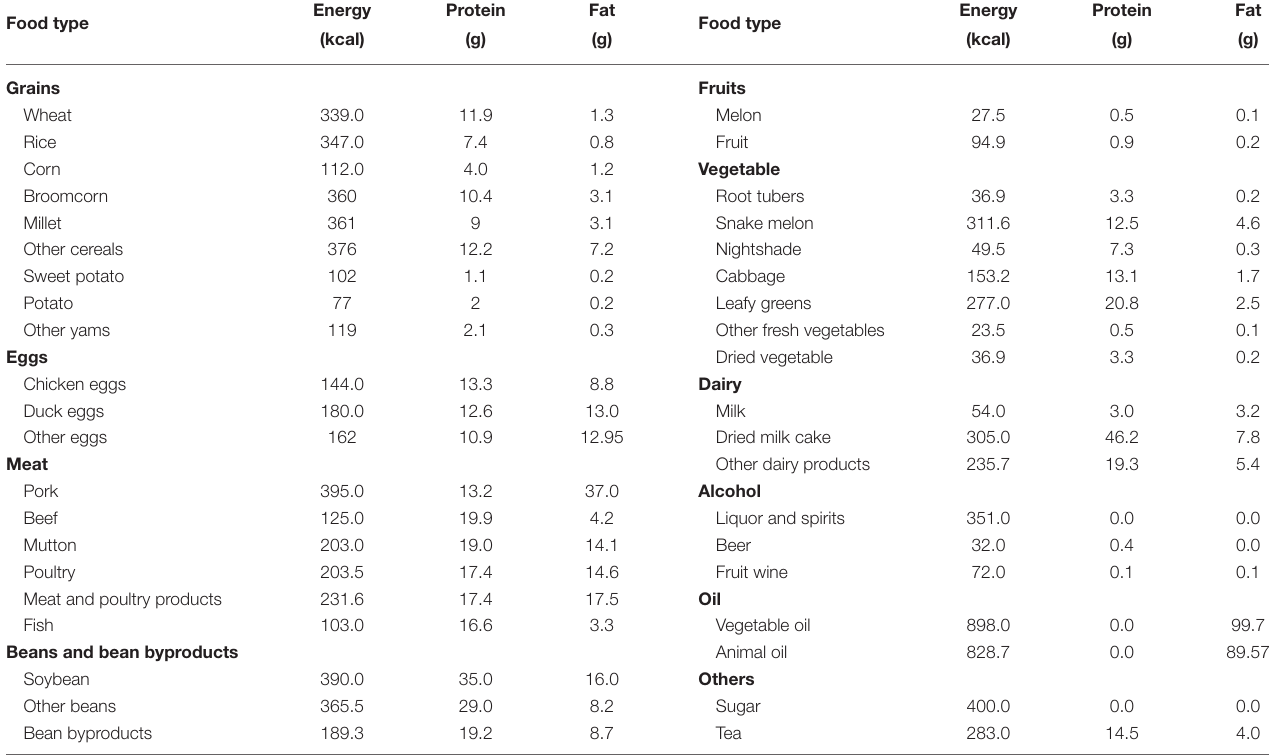
TABLE 4 | Nutritional content of food types (content per 100 g of edible food). Food